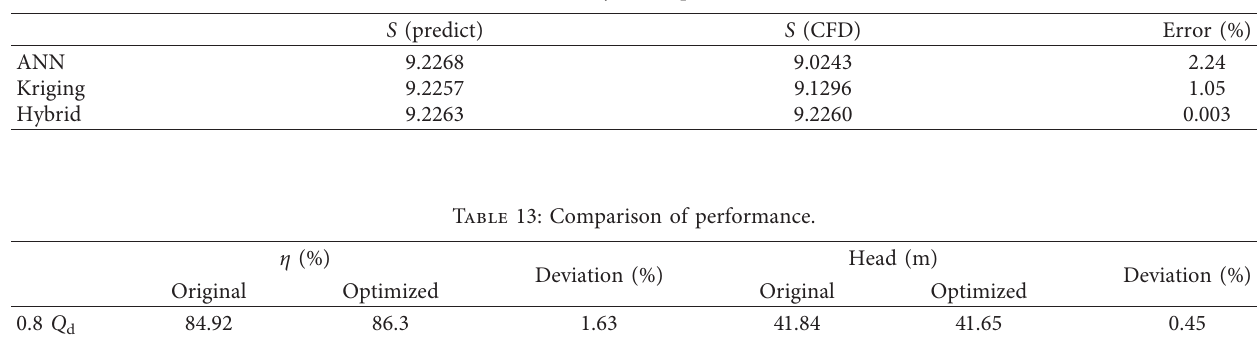
Table 12: Error analysis of optimization results.